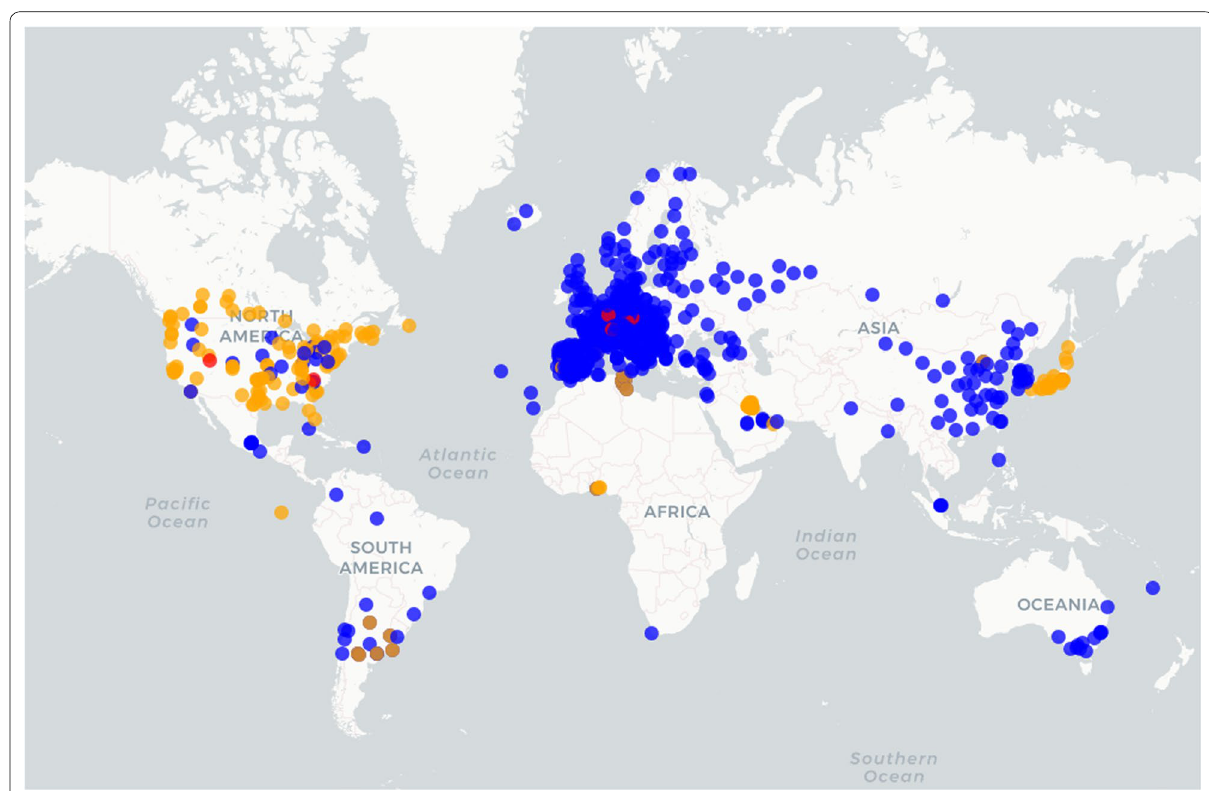
Fig. 1 Screen shot of the interactive map of pollen and fungal spore monitoring stations in the world. The map is web‑based, zoomable down to street level, shows the contact information of each station, and can be searched and displayed according the users’ needs. The map is constantly updated and is available at: https://www.zaum‑online.de/pollen‑map.html; http://www.eaaci.org/patients/resources; https://oteros.shinyapps.io/ pollen_map (accessed 25‑01‑2018). Blue dots (Hirst trap), red (Automatic station), orange (other